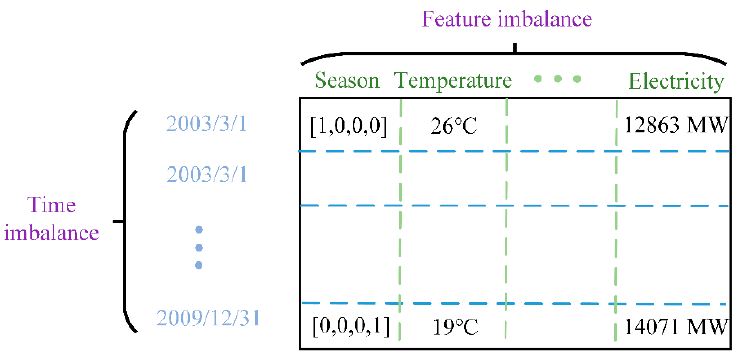
Figure 8. The presentation of input data batch: time imbalance, each row comprises the information at different timesteps; feature imbalance, each column comprises the different features, which can affect the forecasted load.